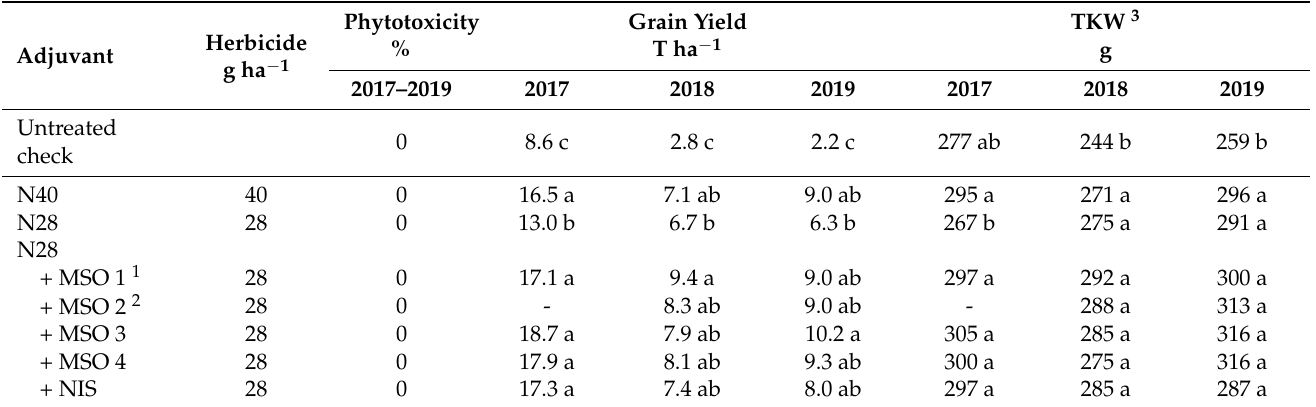
Table 3. Influence of adjuvants on grain yield of